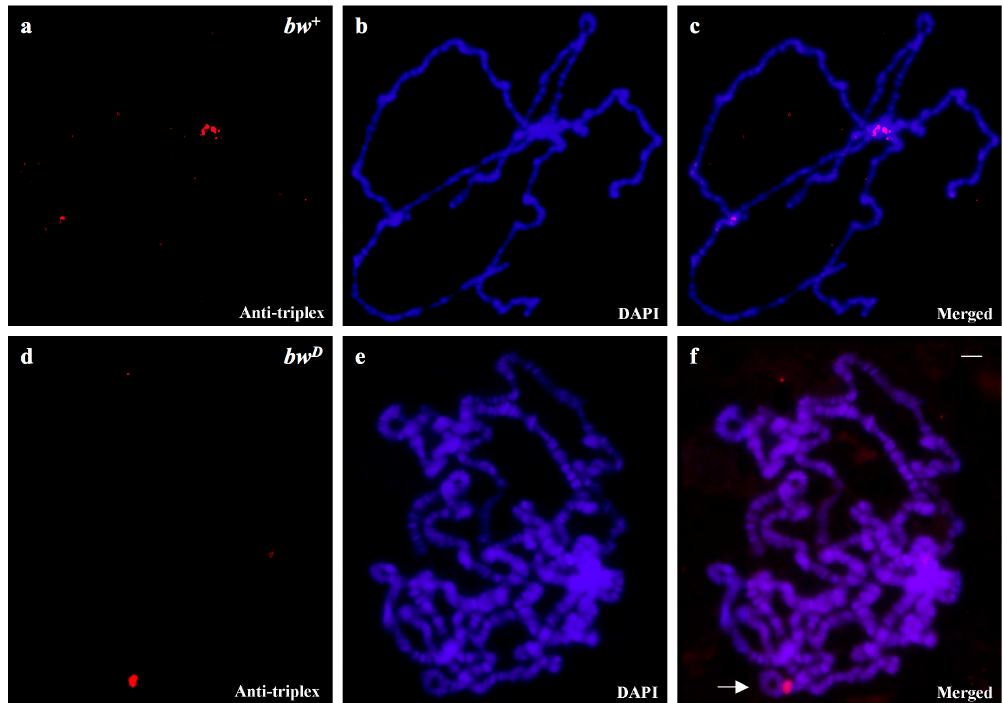
Figure 4. Polytene chromosomes of D. melanogaster from wild type ( bw + ) and y/w/bw D ( bw D ) larvae are shown. Antibody staining ( a , d , Anti-triplex), DAPI staining ( b , e , DAPI) and the corresponding merged signals ( c , f , Merged). The arrow points to the section 59E carrying the bw D allele that is strongly reactive to anti-triplex antibodies. Scale bar corresponds to 20 µ m. Cells 2017 , 6 , x FOR PEER REVIEW 8 of 14